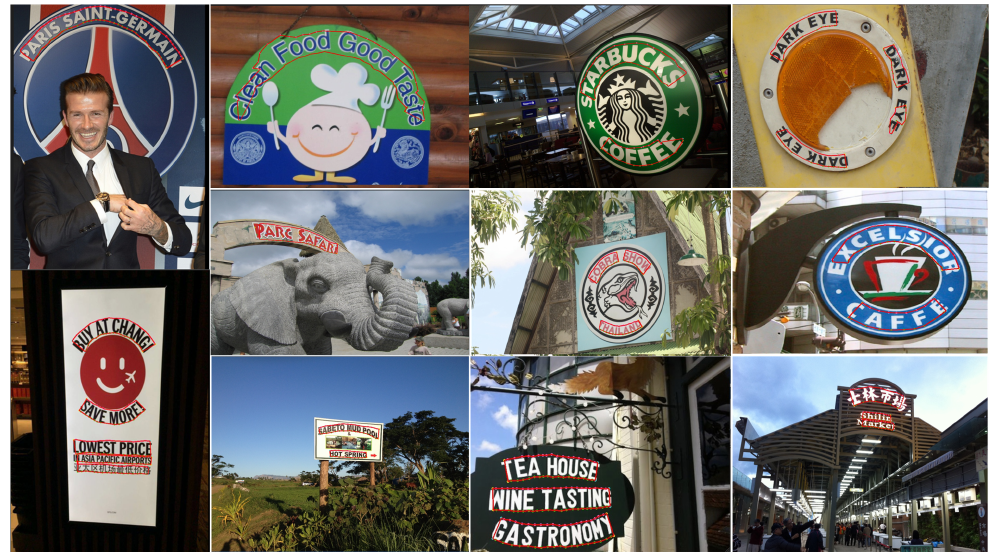
Figure 12. Examples of internet and life scene text